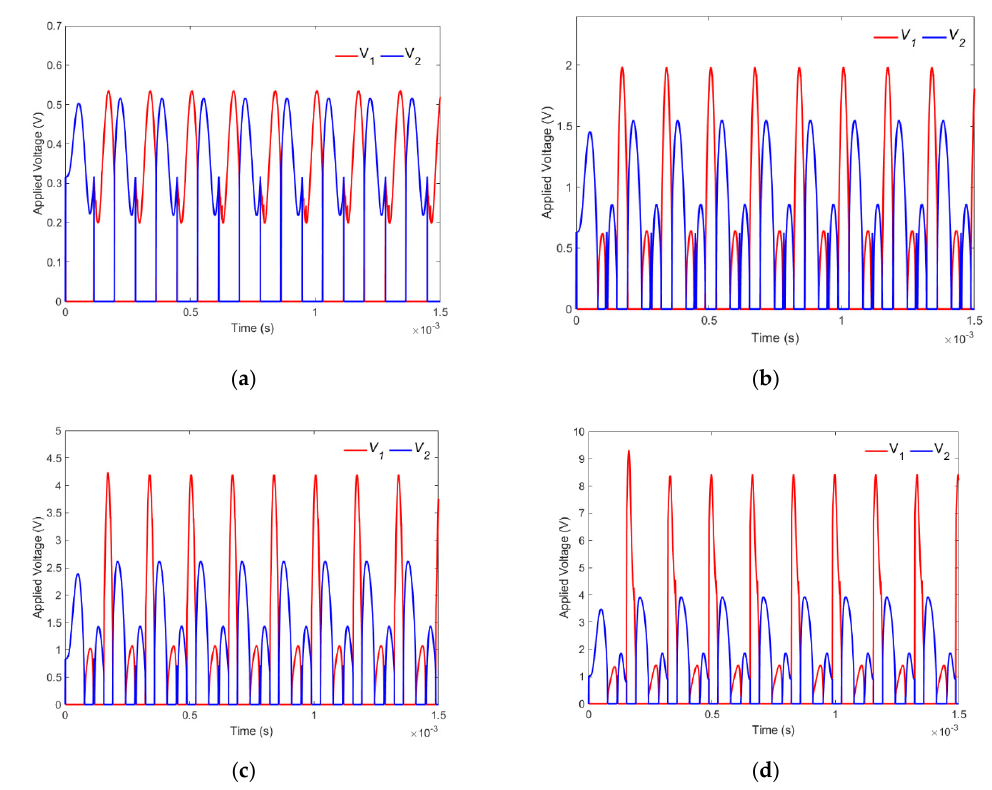
V V ε and 2 versus time for different . V V 0.05 1.05 ε≤ ≤ and 2max for for further V V  0.05 ε= , 1max 2max . However, ε V V , the 1max exceeds the 2max